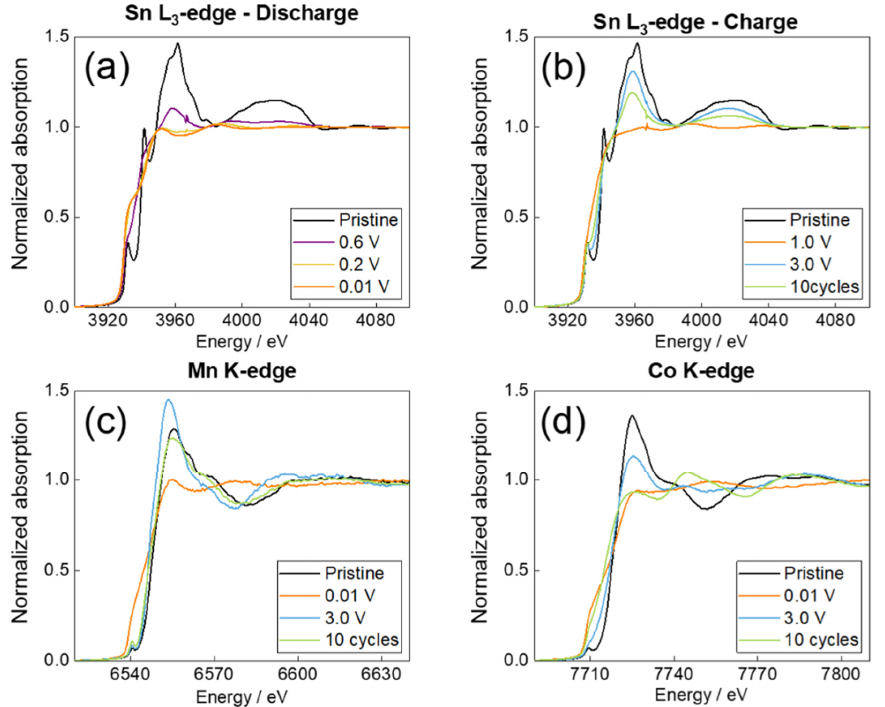
Figure 7. ( a , b ) Ex situ XANES spectra recorded at the Sn L 3 − edge during ( a ) discharge (0.6 V, 0.2 V, and 0.01 V) and ( b ) charge (1.0 V, 3.0 V, and after 10 cycles at 3.0 V). Both panels include also the spectrum recorded for the pristine electrode for direct comparison. ( c , d ) Ex situ XANES spectra rec- orded at the ( c ) Mn K − edge and ( d ) Co K − edge, including the spectra of the pristine electrode as well as the electrodes discharged to 0.01 V and re-charged to 3.0 V after one complete cycle and 10 cycles. Complementary information concerning the electrochemical reaction was revealed by the Mn and Co K − edge ex situ XANES spectra (Figure 7c,d, recorded in fluorescence mode due to the low TM concentrations). In Figure 7c, the evolution of the Mn K − edge from the pristine state to the fully discharged state (0.01 V) and back to the fully charged state (3.0 V) and the fully charged state after 10 cycles is depicted. The same plot is shown for the Co K − edge in Figure 7d. In the pristine state, both TMs were located in 2a Wyckoff sites, replacing Sn in the rutile SnO 2 structure. The spectra of the fully discharged elec- trodes (0.01 V) confirmed the presence of metallic Mn and Co, suggesting the complete reduction in both TM dopants. This finding was confirmed by analysing the extended X- ray absorption fine structure (EXAFS) data (Figure S2). Upon charging, both TMs were reoxidized at 3.0 V, which was still the case on charging after 10 cycles. The local environ- ment, however, changed after cycling, as apparent from the differing spectral features compared with the pristine state, indicating that the two TMs appeared to form other ox- ides with distinct structural environments. A more detailed analysis of the local coordina- tion, though, is difficult due to the very low signal-to-noise ratio of the EXAFS data (Figure S3). Nevertheless, the ab initio XANES simulation of some Mn- and Co-based oxides pro- vides further insights into the possible compounds formed upon cycling, as discussed in the following.